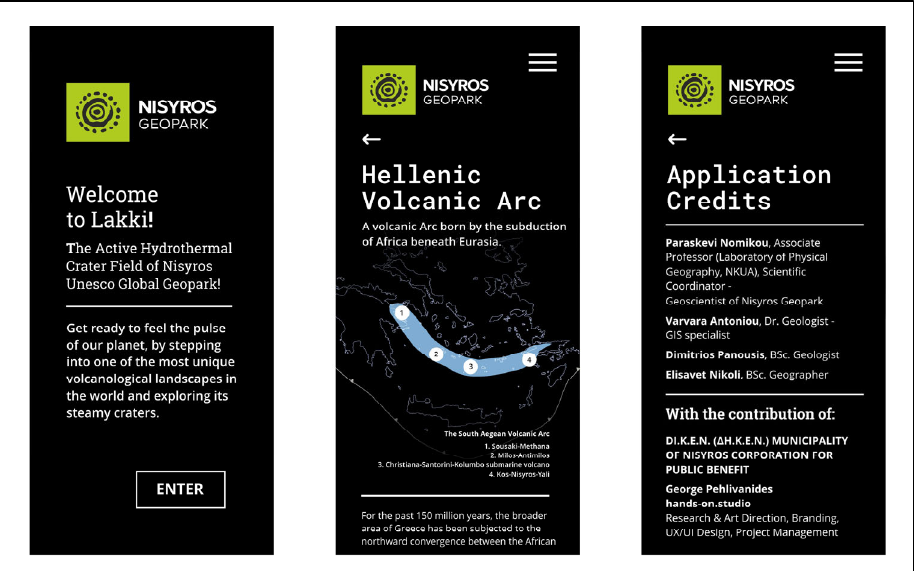
Figure 14. Screenshot examples of the contents of Nisyros Volcano App. Here, the opening page, ‘Hellenic Volcanic Arc’ and ‘App Credits’ subunits are the ‘Hellenic Volcanic Arc’ and ‘App Credits’ subunits are presented.